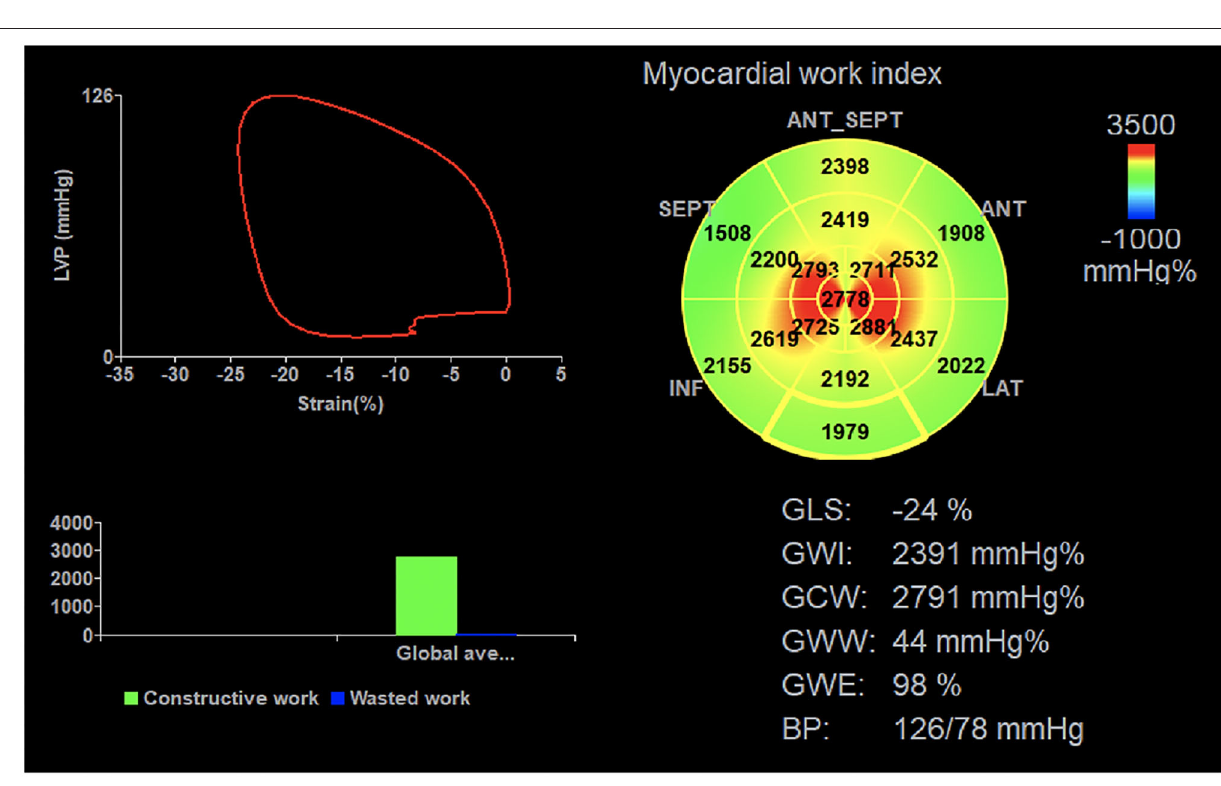
Frontiers in Cardiovascular Medicine | www.frontiersin.org